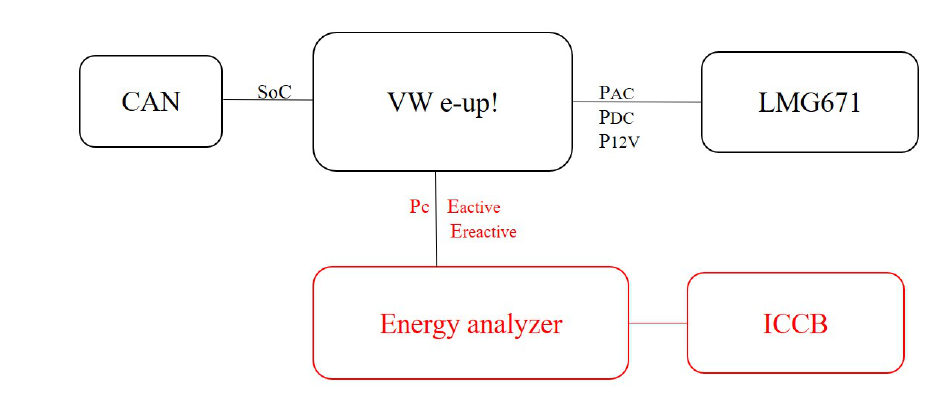
Figure 5. Schematic illustration of the overall measurement setup for charging.